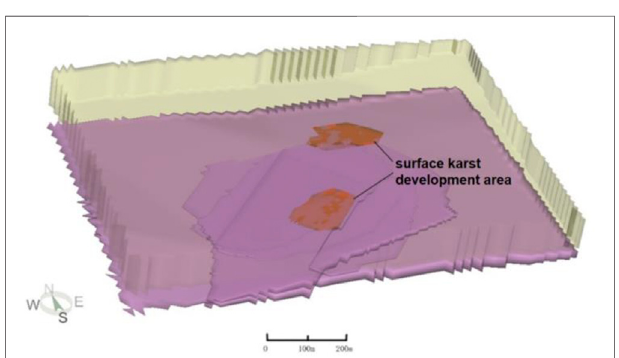
FIGURE 7 | 3D shape of karst distribution in Qiaomuwan karst collapse area of Fenghuo Village.